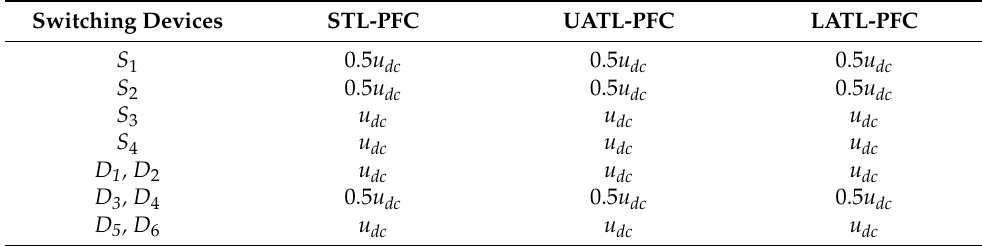
Table 2. Maximum voltage stresses of the switching devices in the proposed topologies.